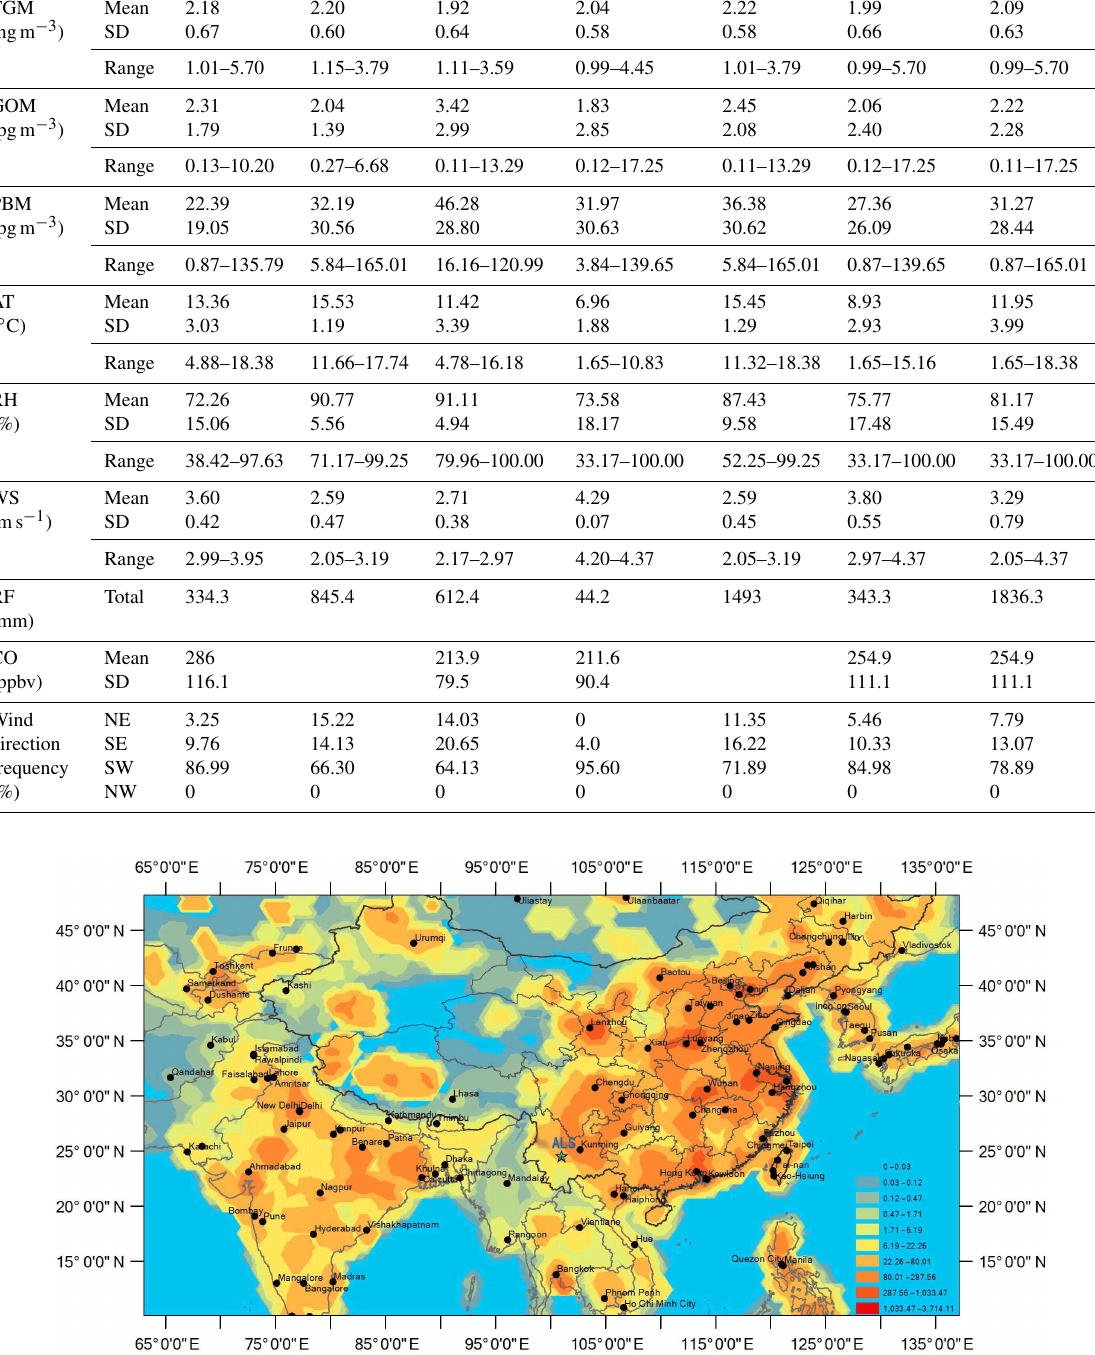
Figure 1. Map showing the location of ALS, anthropogenic mercury emissions (gkm − 2 yr − 1 ) and major cities in Asia (AMAP/UNEP,